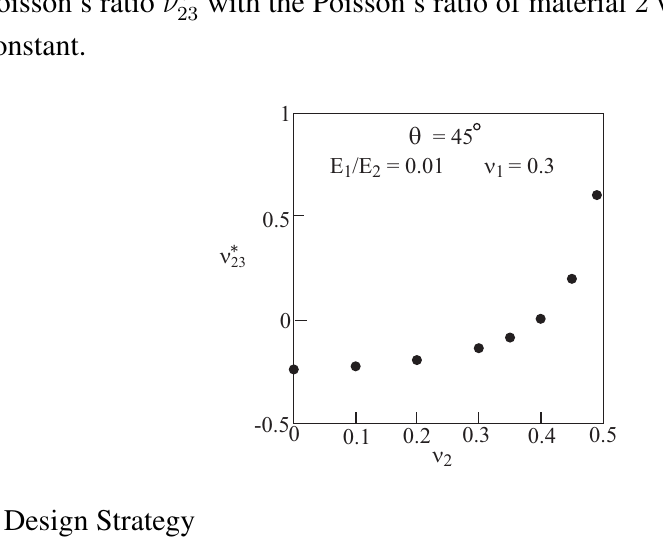
, optimal material 2 properties in re-entrant 23